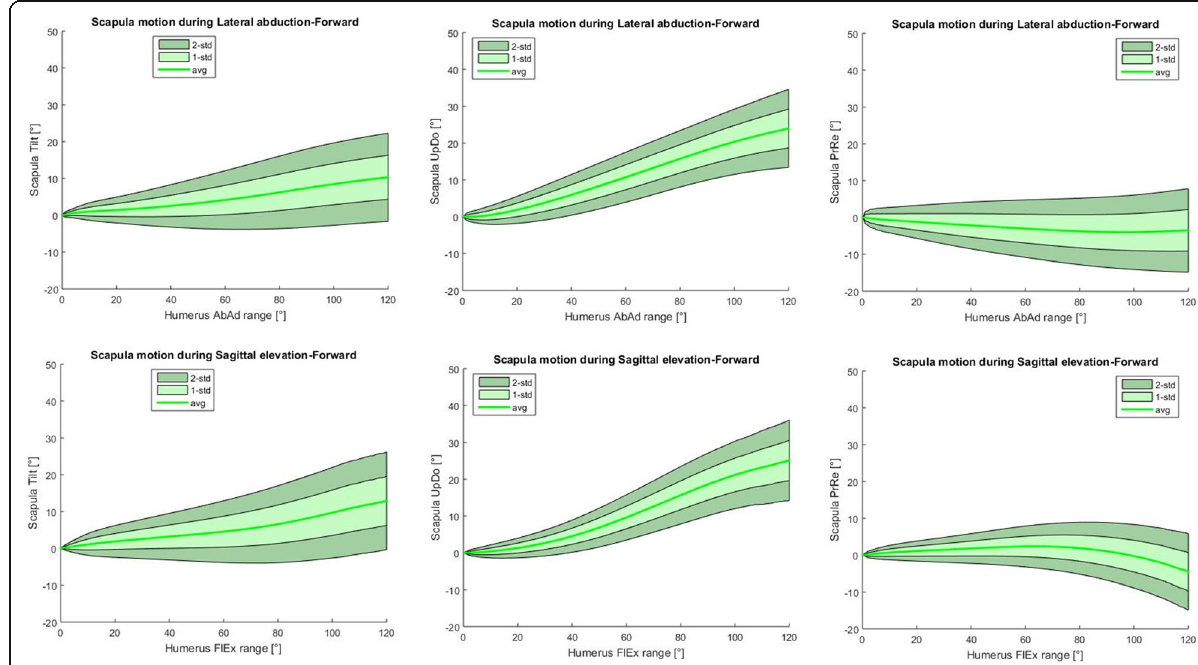
Fig. 4 normative data for all six graphs comparing the variations of the three scapular angles studied (upward/downward rotation [Scapula UpDo], internal/external rotation [Scapula PrRe] and anterior/posterior tilt [Scapula Tilt]) against the variations in total shoulder abduction (Humerus AbAd range) or flexion (Humerus FlEx range). The green shade areas are the prediction bands for 1 SD (light green) and 2 SD (dark